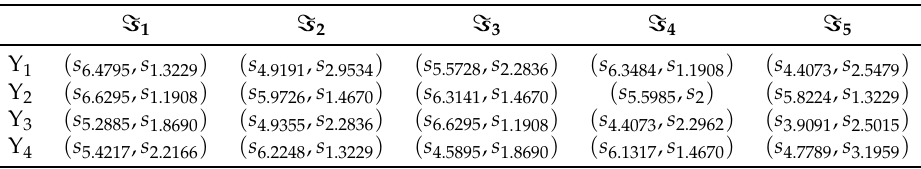
Table 5. Decision matrix by using LPFOWG operators.